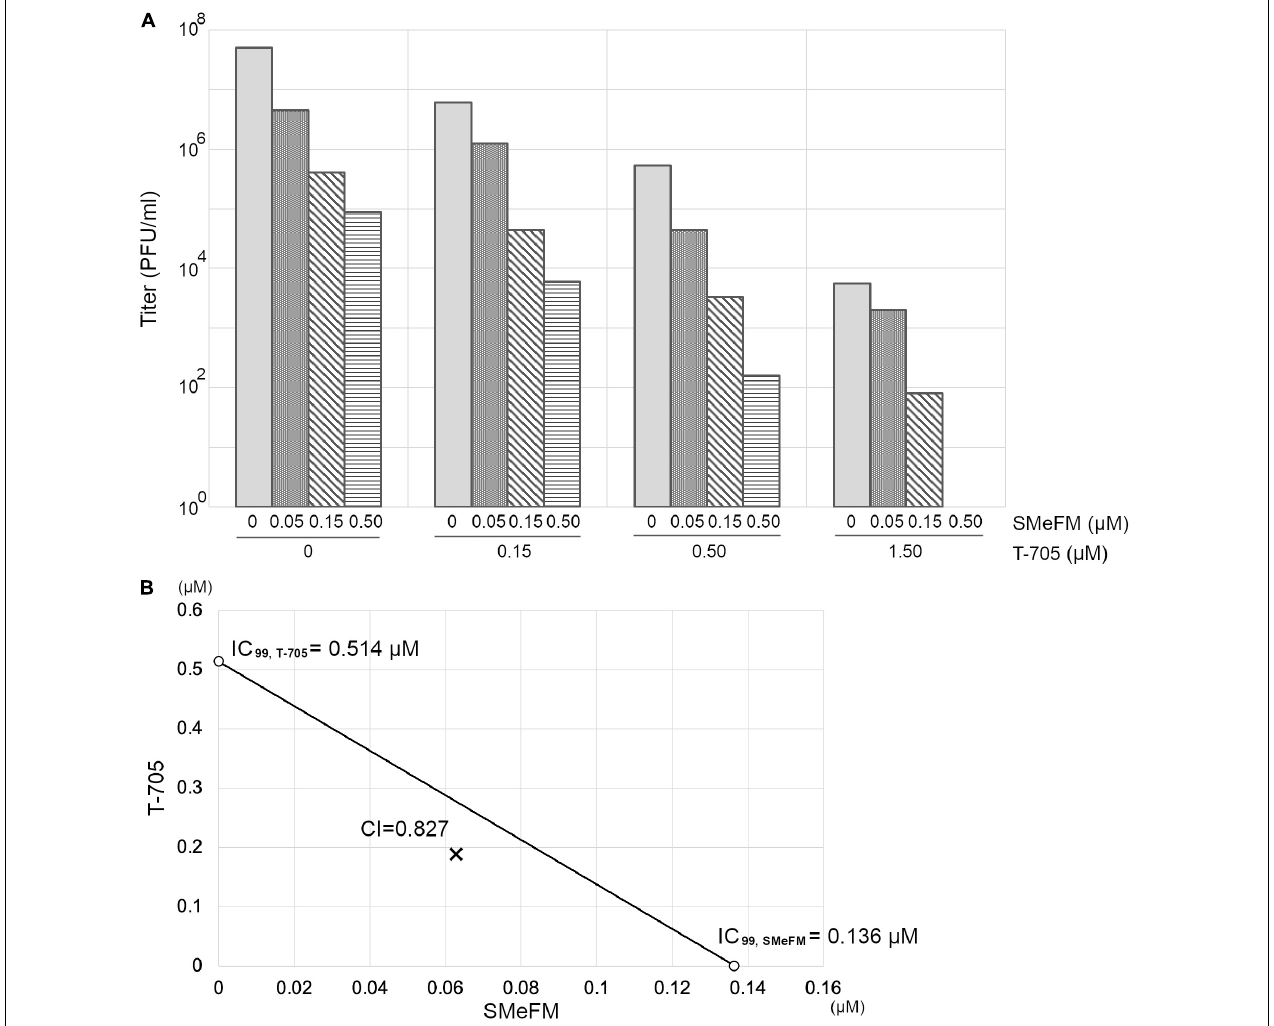
FIGURE 3 | Anti-influenza virus activity of T-705 does not affect that of SMeFM. (A) Inhibition of IAV propagation by the combination of SMeFM and T-705. MDCK cells were infected with wild type virus (WSN strain) at an MOI of 0.01 and incubated with the indicated concentration of SMeFM and T-705 for 24 h. The virus titer in the supernatant was determined by plaque assay. (B) Isobologram analysis of the combination of SMeFM and T-705. The individual doses of SMeFM and T-705 to achieve 99% growth inhibition (IC 99 ) were plotted on the X- and Y-axes. The line of additivity on the isobologram represents the 99% growth inhibition level of each drug. The combination index (CI) is represented by the X symbol above (CI > 1, indicating antagonism between drugs) or below (CI < 1, indicating synergy) the line (CI = 1, indicating additive